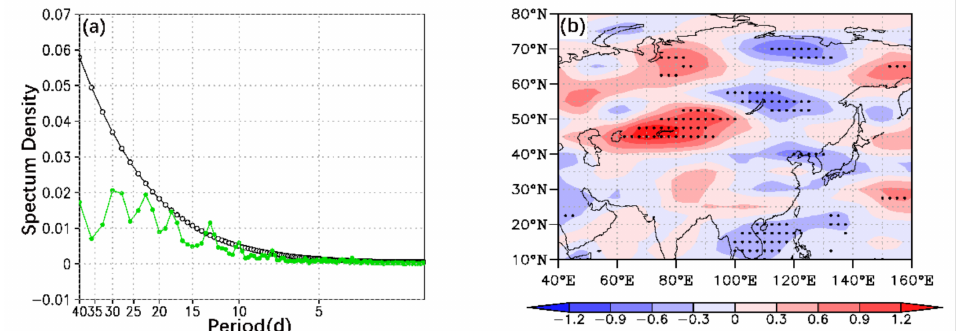
Figure 6. ( a ) The power spectrum of 300 hPa zonal wind field in the key area of PFJ during the years of WPECEs (green line is the spectrum density, black line means 95% red noise test). ( b ) The synthesis of the anomaly of the 10–20 d filtered zonal wind standard deviation of 300 hPa during the years of WPECEs (unit: m/s). The doted regions are for values significant at or above the 95% confidence